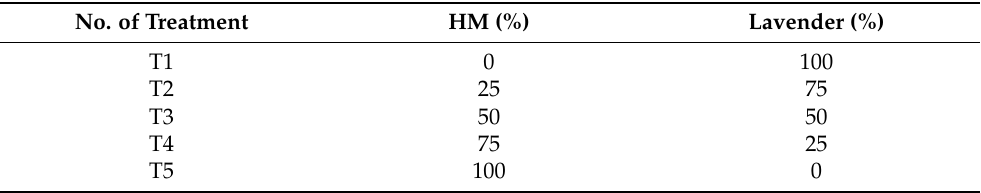
Table 1. Description of different treatments of horse manure (HM) and lavender waste used for the vermicomposting